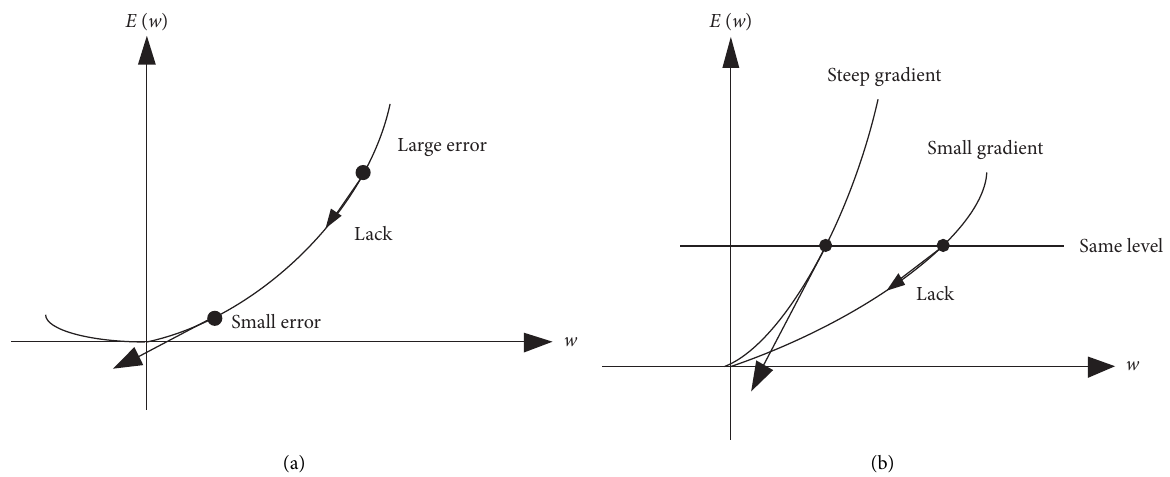
Figure 4: Effect of step-size on error. (a) Step-size not dependent on the separation error (b). Step-size is proportional to the gradient of the